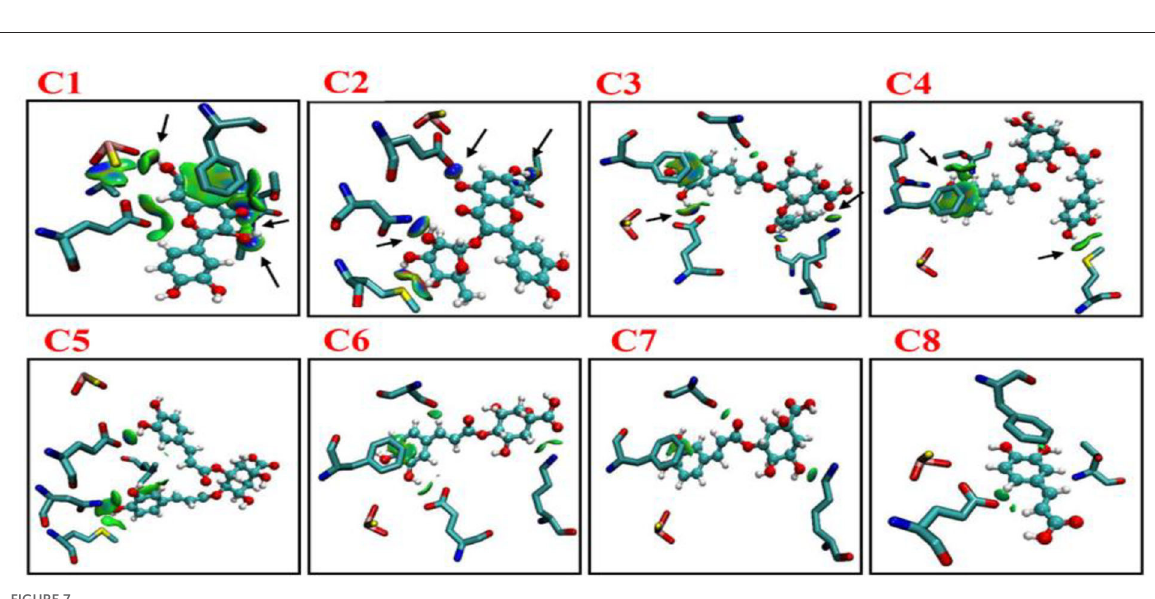
compounds does not rely on the quinic or caffeoyl